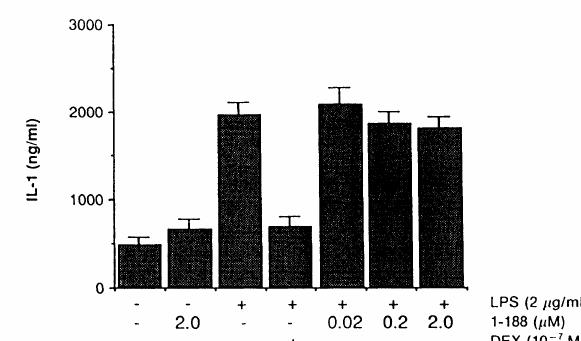
FIG. 3. Monocyte IL-lfl release: effects of 188aa N-terminal fragment of lipocortin 1. Peripheral blood monocytes were cultured for 48 h in the presence of LPS 2/g/ml, dexamethasone 10 -7 M (DEX), and N-terminal 188 amino acid lipocortin fragment 2 x 10-8-2 x 10 -6 M (1-188), and the IL-lfl concentration in culture supernatants measured by ELISA. 1-188 did not reproduce the inhibition of monocyte IL-lfl release observed with